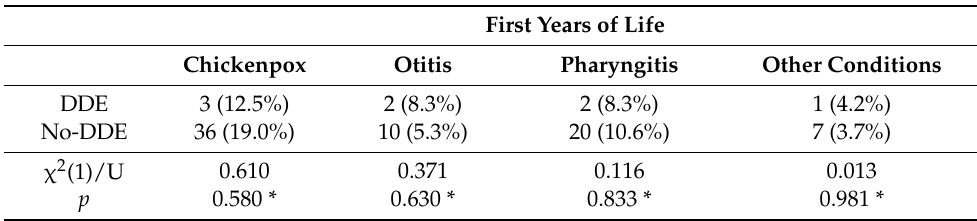
Table 4. Statistical comparisons between DDE and no-DDE groups regarding parameters related to conditions during the first years of life. First Years of Life Chickenpox Otitis Pharyngitis Other Conditions DDE 3 (12.5%) 2 (8.3%)